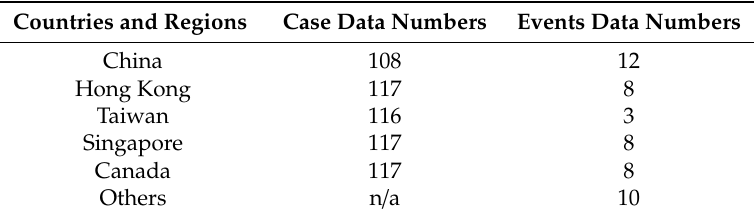
Table 1. Raw data collected for the SARS